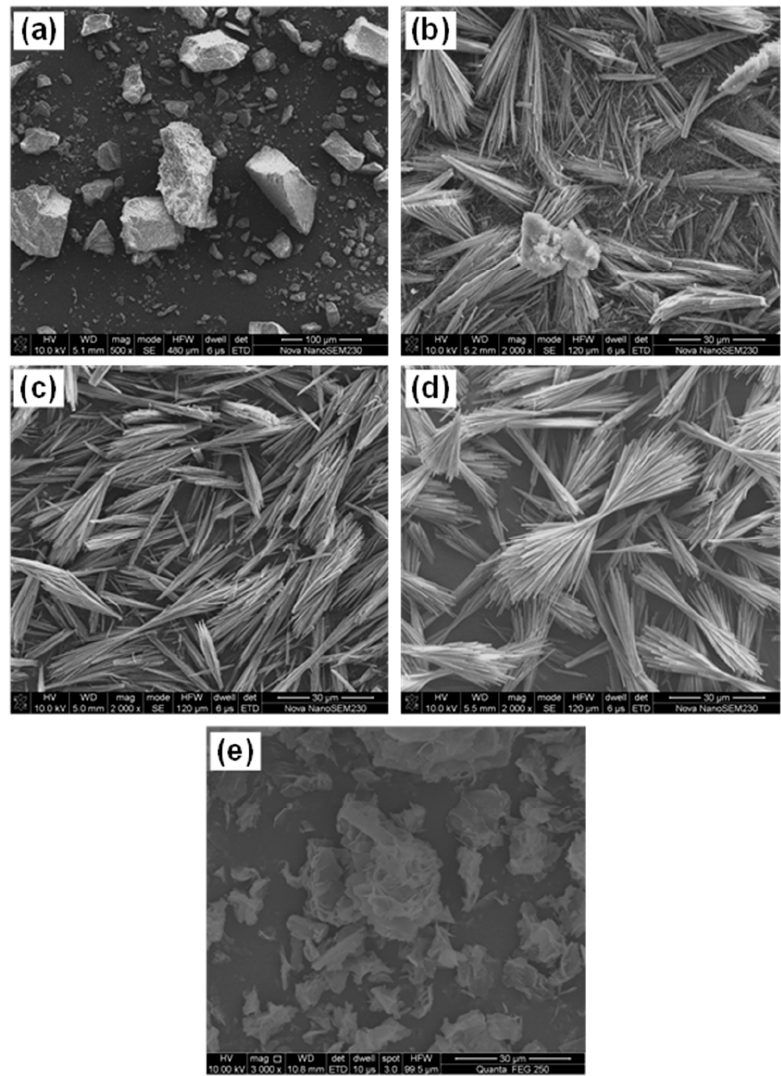
Figure 11. SEM images of whiskers obtained at different hydrothermal temperatures ( a ) 120 °C; ( b ) 140 °C; ( c ) 160 °C; ( d ) 180 °C; ( e ) 200 °C.